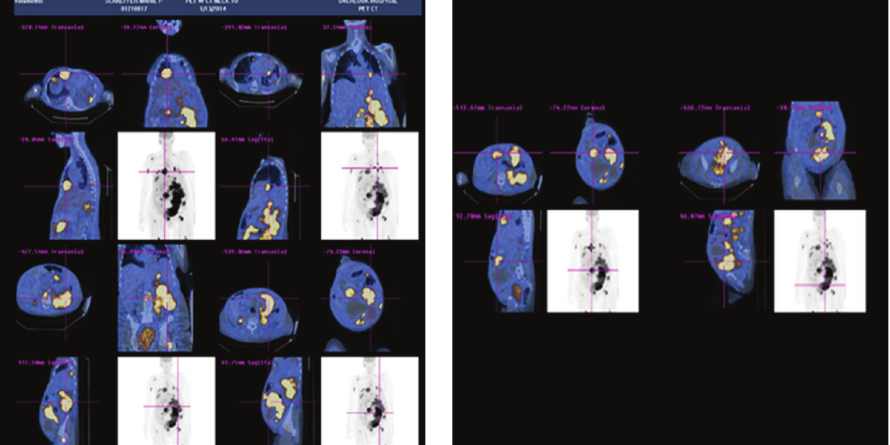
Figure 5: WHOLE BODY PET-CT showing multiple areas of hypermetabolic activity in the abdomen with hypermetabolic bony lesions suspicious of extensive metastatic